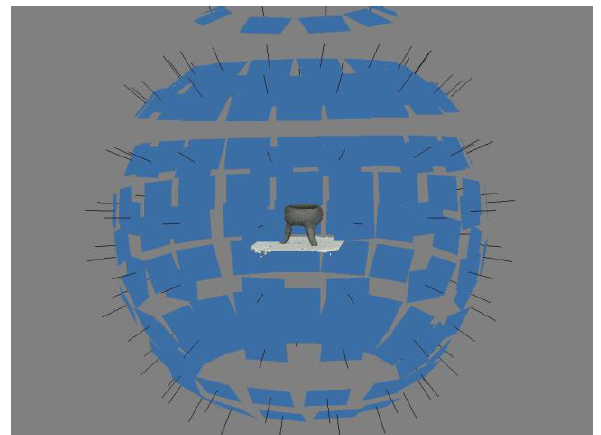
Figure 4: A snapshot of properly aligned photographs using the “apply masks to tie points” method;